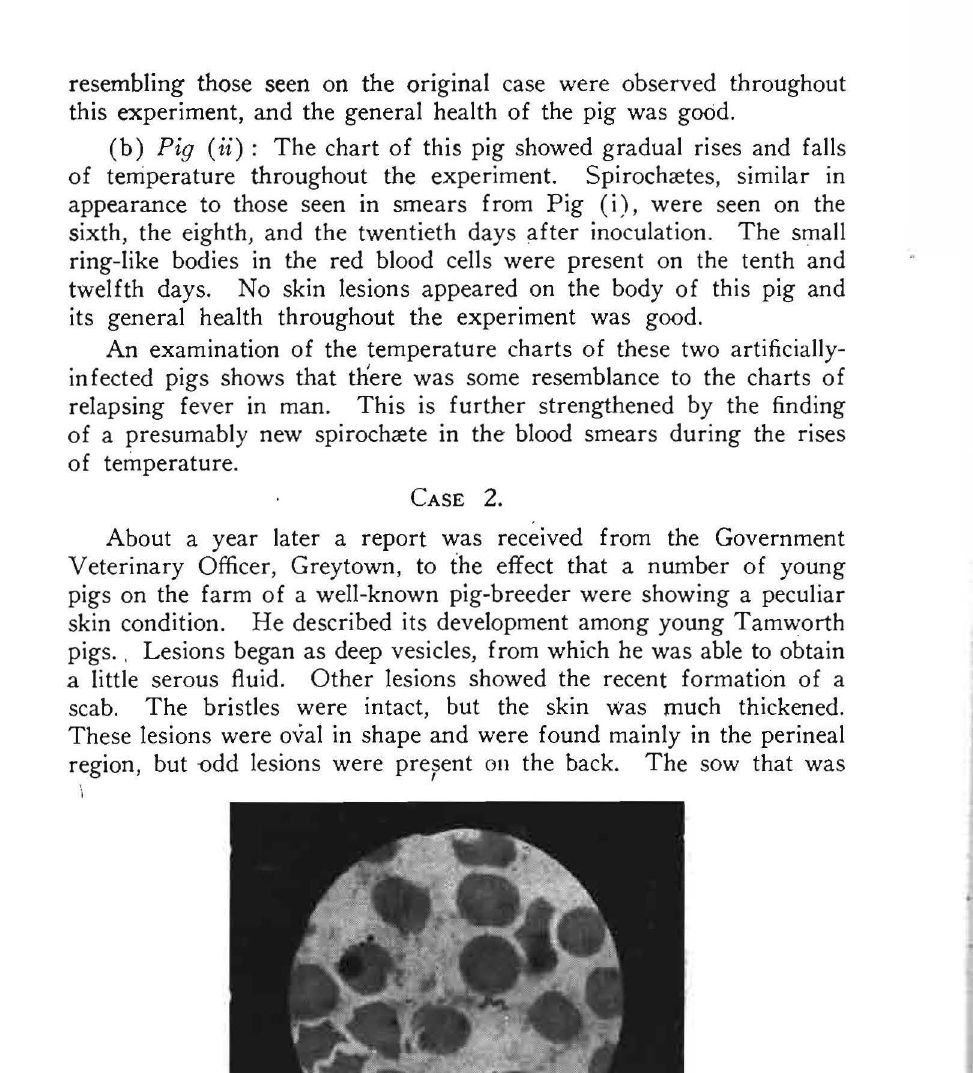
Fig. 4. - SpirochfEte in blood